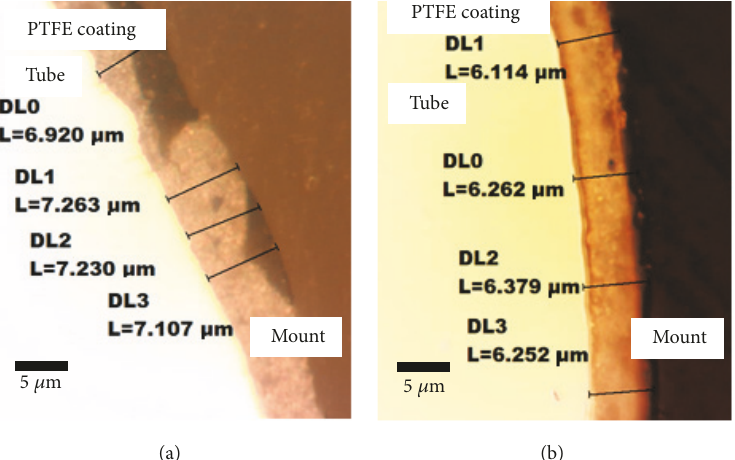
Figure 4: Optical micrographs of the cross-sectional area of the sample at different spin speeds: (a) 100 rpm and (b) 500 rpm (viscosity of 1100mPa ⋅ s, withdrawal rate of 20mm/s, and immersion time of 20